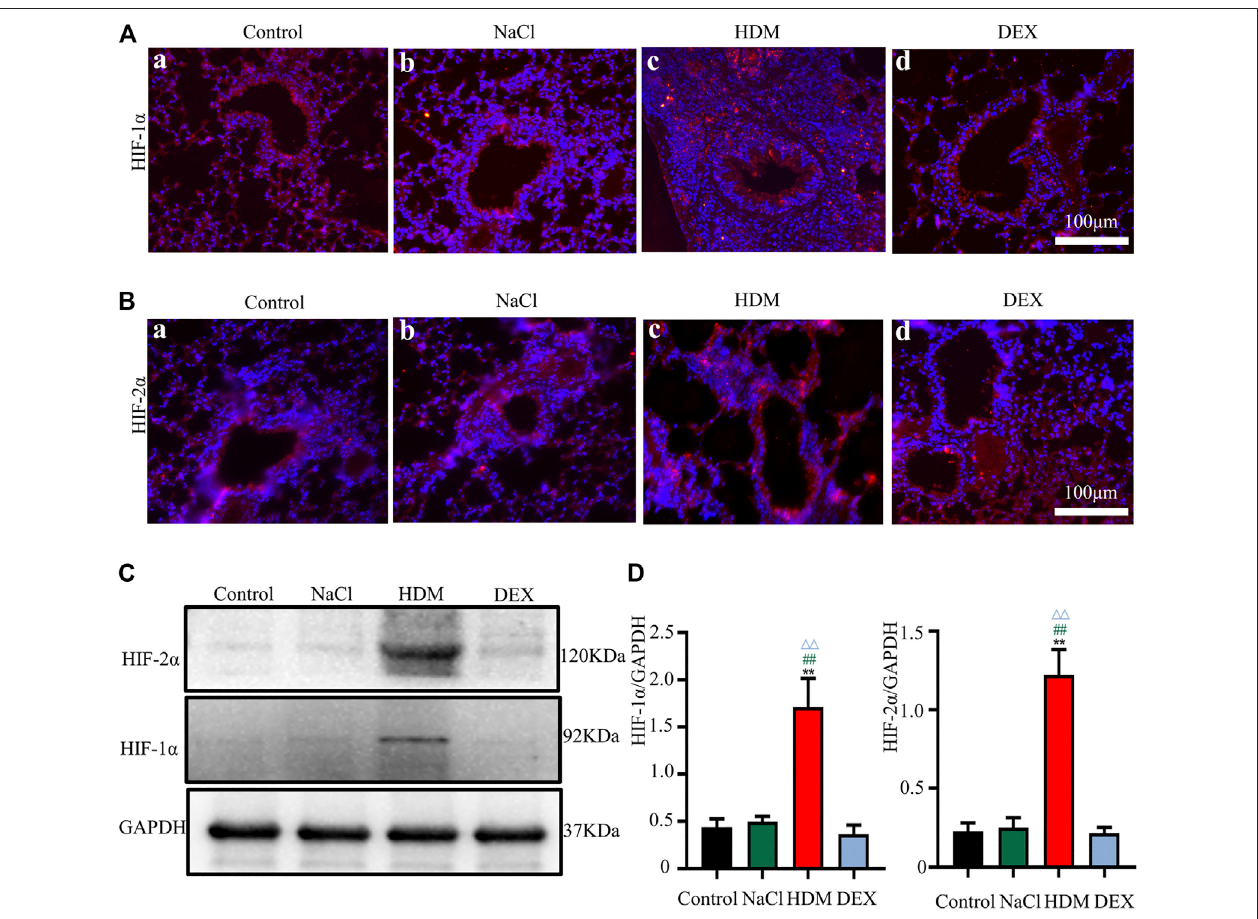
FIGURE8| TheexpressionofHIF-1 α andHIF-2 α inthelungwasincreasedintheHDMgroup. [A(a-d)] ExpressionofHIF-1 α inthelungtissue. [B(a-d)] Expression ofHIF-2 α inthelungtissue. (C) Theproteinexpression ofHIF-1 α and HIF-2 α inthelungtissuesofmicewasdetectedbyWestern blot. (D) Theresults ofthewesternblot were quanti fi ed. n (cid:1) 3. ** p < 0.01 between HDM group and Control group. ## p < 0.01 between HDM group and NaCl group. △△ p < 0.01 between HDM group and DEX group.